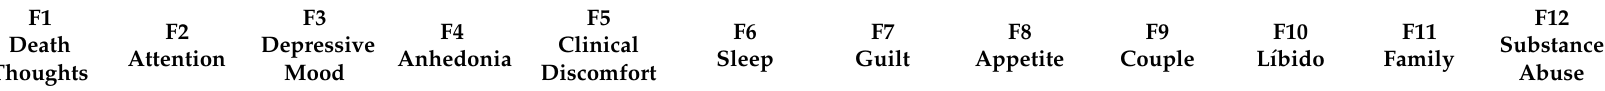
Table A1. Saturations and factorial structure of the DCET items at the moment “month” (N =